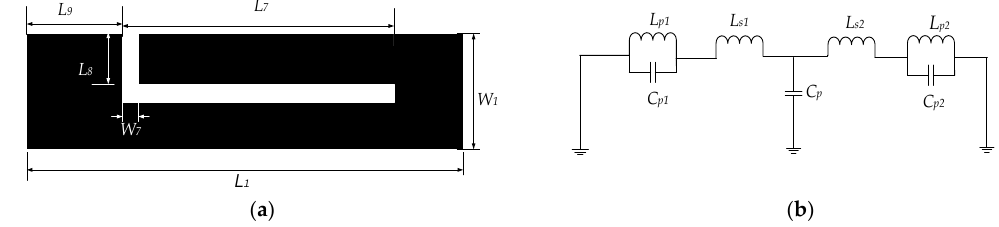
Figure 5. ( a ) The element structure of L-shaped defect microstrip structure; ( b ) the equivalent lumped circuit of T-shaped resonator and L-shaped defect microstrip structure.